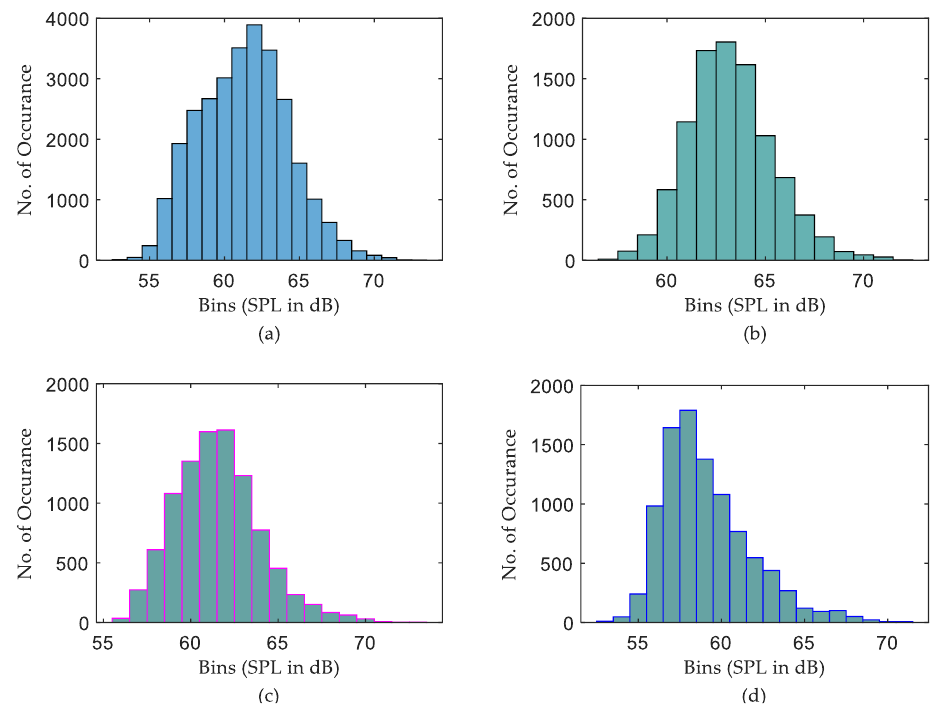
Figure 14. Histogram calculation of ICU3 data over 20 days, ( a ) distribution of SPLs over the entire period, ( b ) distribution of SPLs over daytime, ( c ) distribution of SPLs over evening, and ( d ) distribution of SPLs over night.